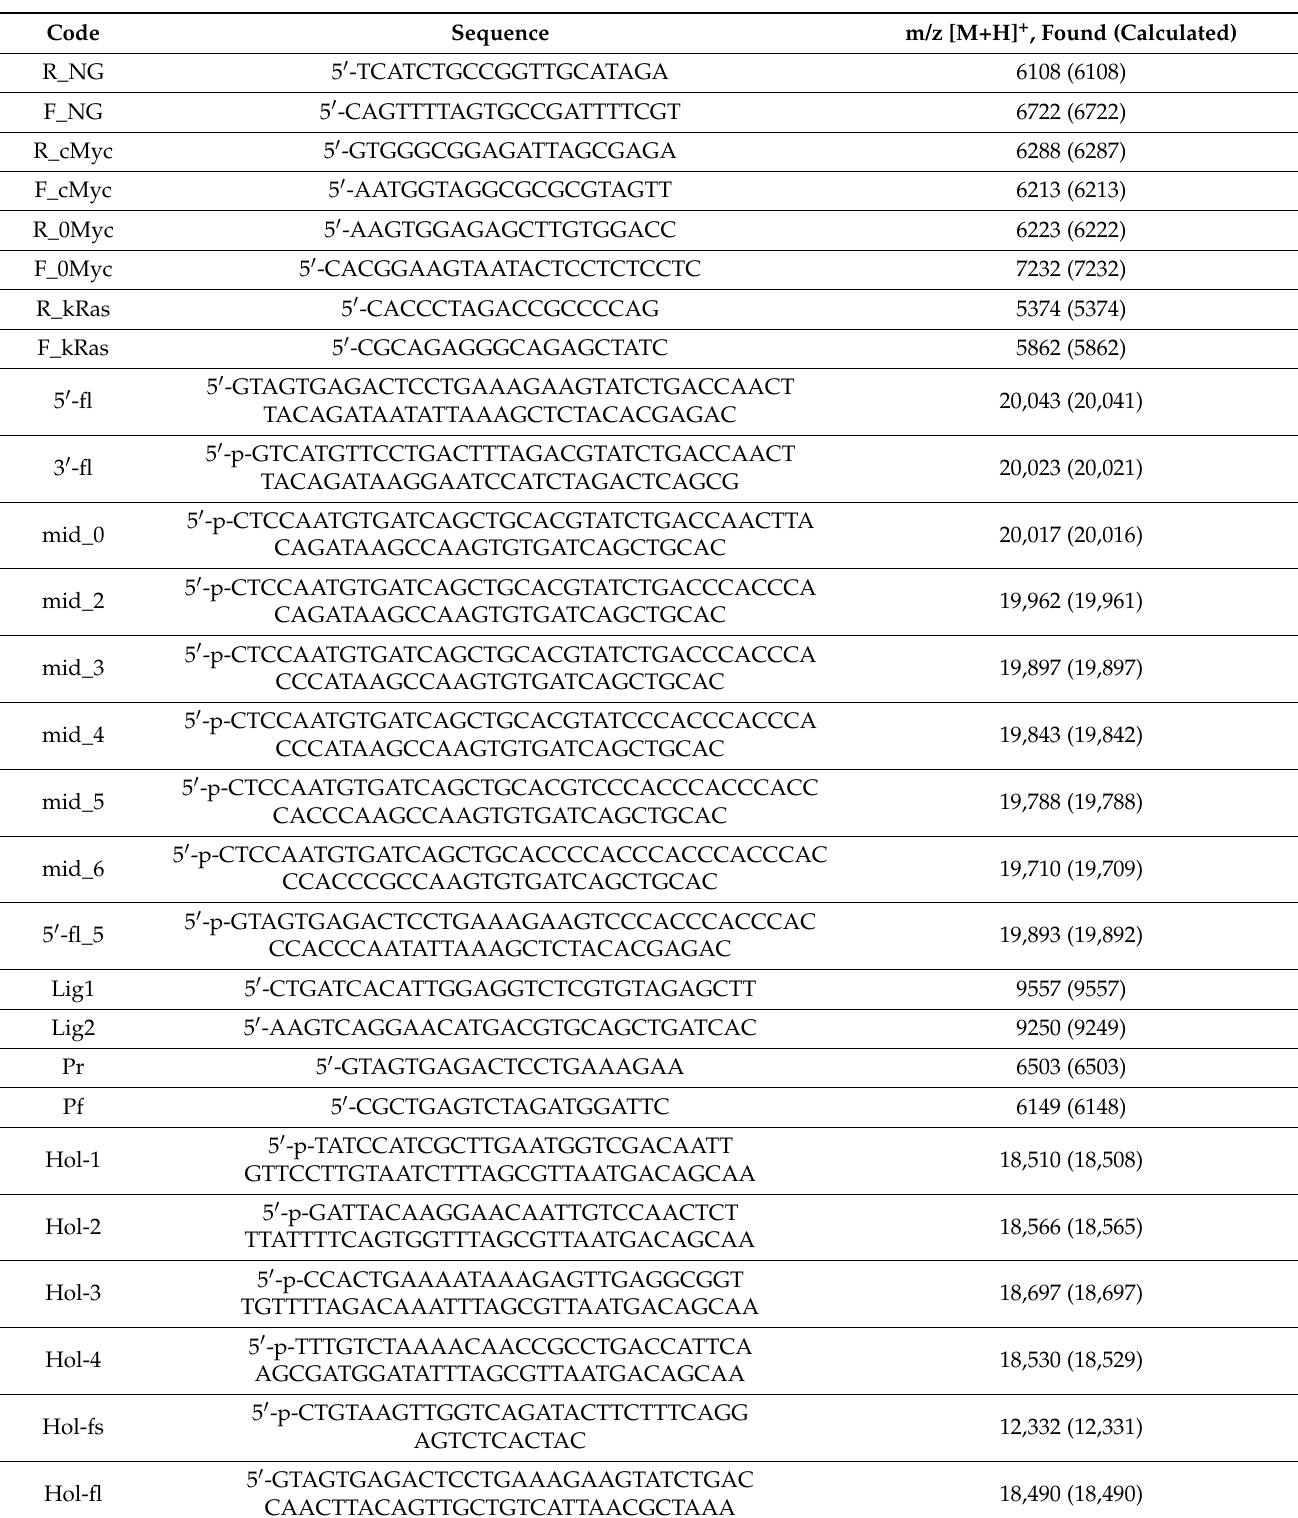
Table 1. Oligonucleotide sequences and MS